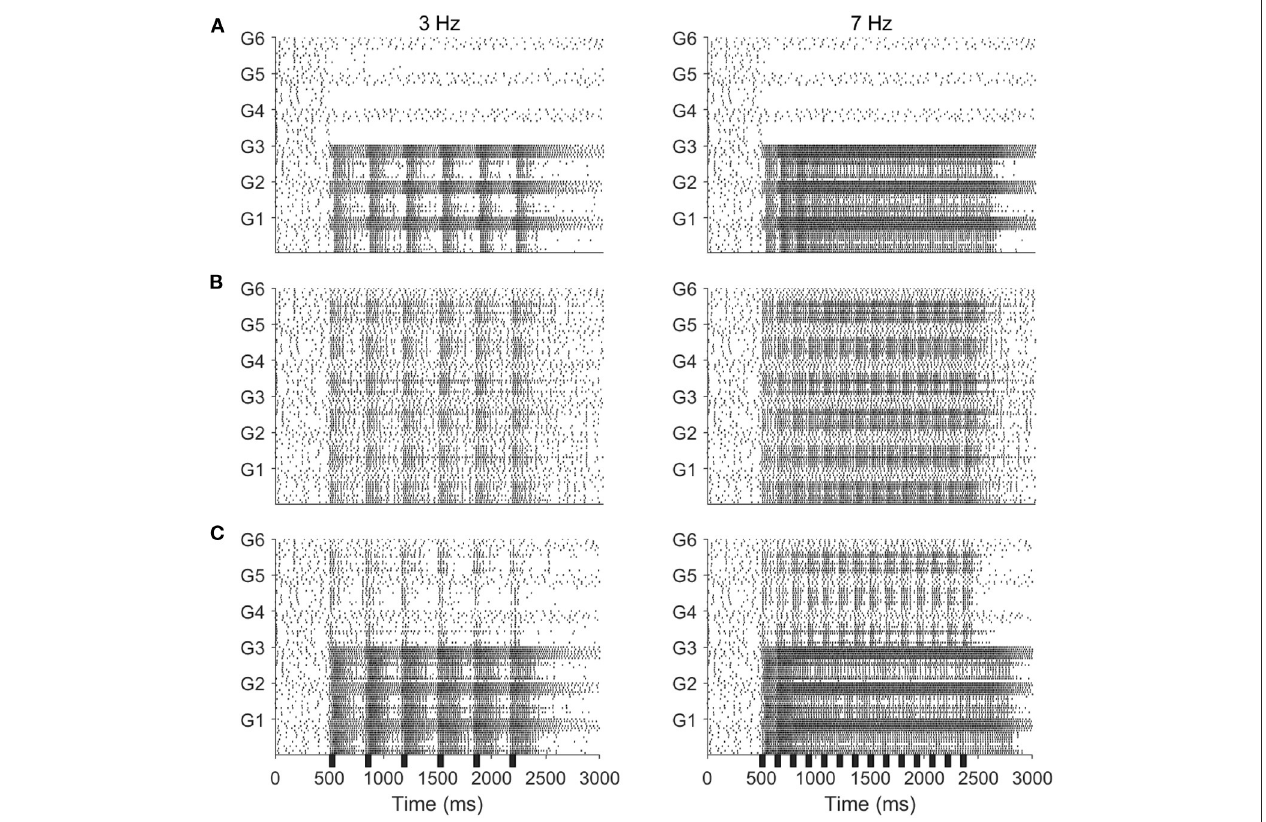
FIGURE 5 | Spike rasters of the model network for 50 ms stimulus pulses delivered at a frequency of 3 Hz (left) or 7 Hz (right), in the odor only (A) , mechanosensory only (B) , and additive sensory integration (C) stimulus scenarios. Odor is simulated by sending stimulus current to only cells within glomeruli 1, 2, and 3, while mechansensory input is simulated by sending stimulus current to cells within all glomeruli. Within each glomerulus, the bottom 10 cells are PNs while the top six cells are LNs. Black bar represents